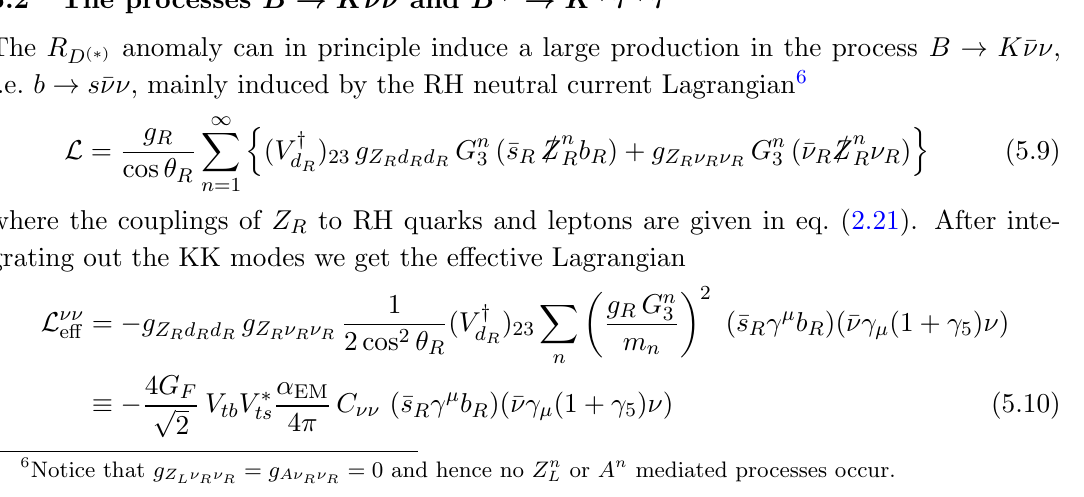
(brown lines) and by T for L (cid:28) R (cid:28) R FB